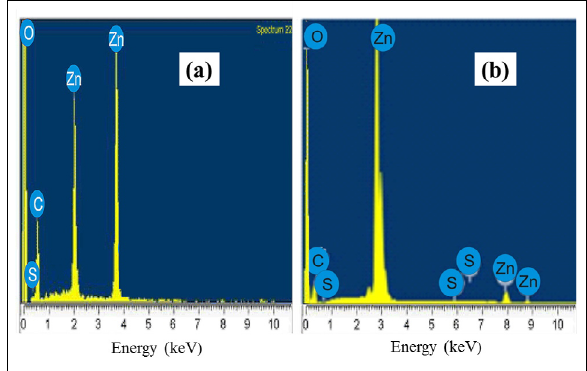
Energy dispersive X-ray analyser spectra of (a) ZnO_CNPs and (b) ZnO_MNPs showing a 1:1 atomic ratio of Zn and O. were much smaller, with an average size of 14.71 nm, most of which were hexagonal and less agglomerated, as observed previously in the SEM result (Figure 2b). The agglomeration observed in the particles is the result of high surface energy, usually associated with synthesis occurring in an aqueous medium. 13 The disparity in the degree of particle dispersion and size in ZnO_CNPs and ZnO_MNPs could be attributed to the different types of biomolecules present in the extracts and the extent to which they were involved in the capping